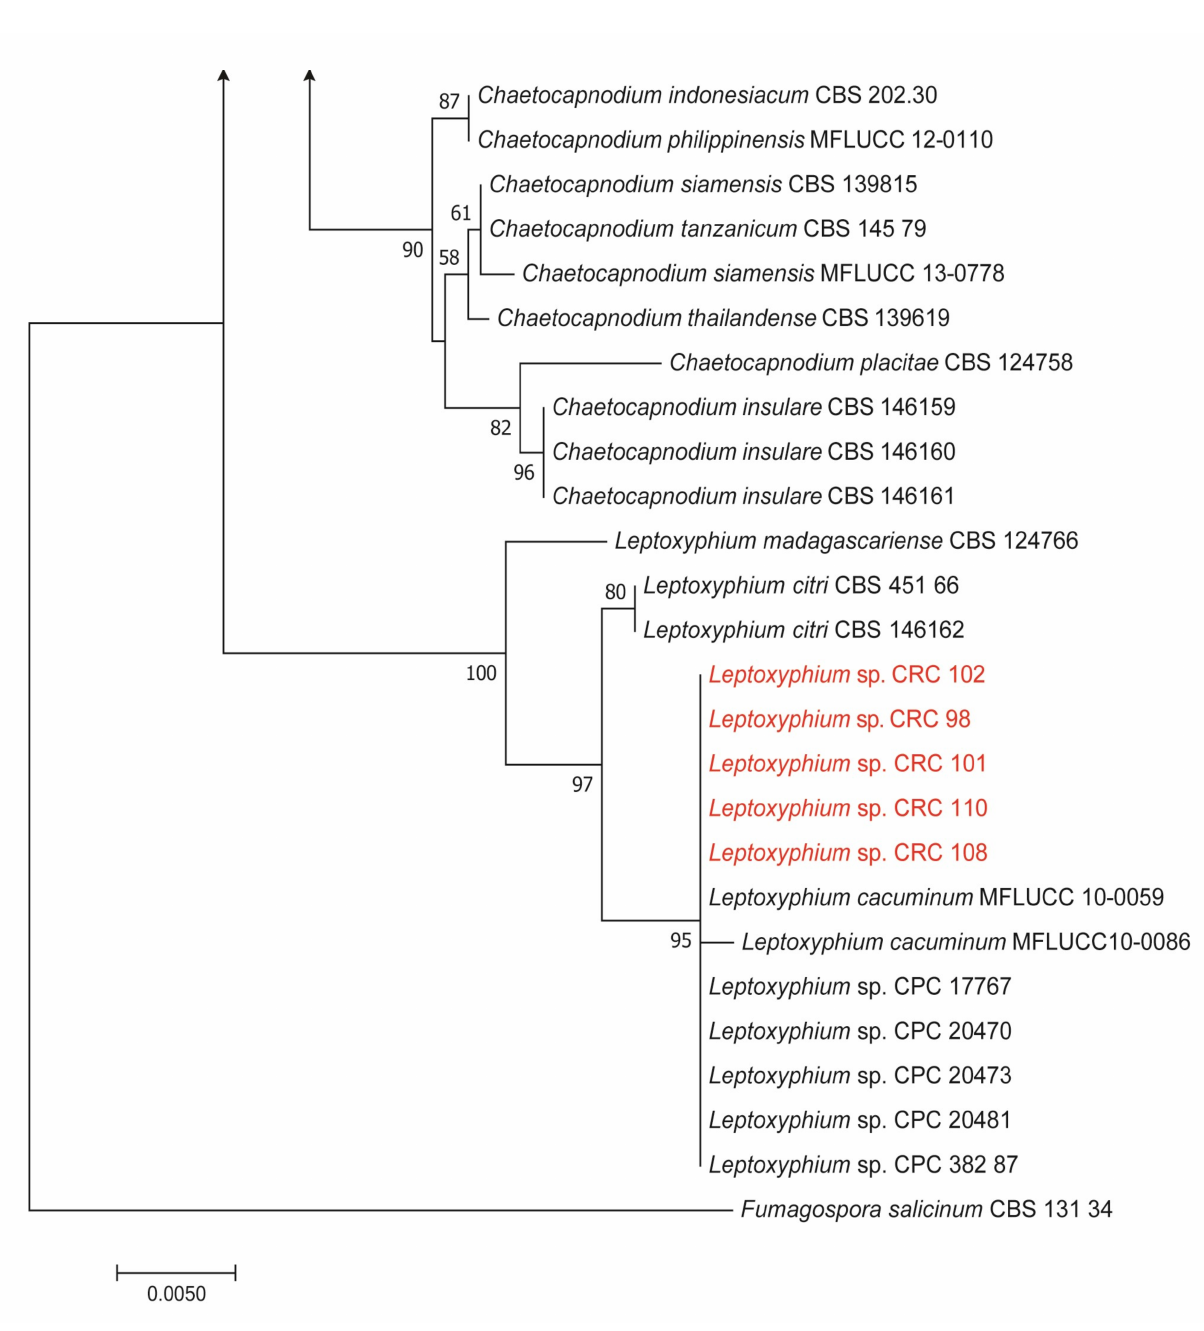
Figure 1. Neighbor-joining phylogenetic tree of Capnodiaceae generated based on the combined LSU and ITS. Bootstrap support values for neighbor-joining phylogeny equal to or higher than 50% are displayed on the nodes. The newly generated strains in this study are indicated in red. The tree is rooted to Fumagospora salicinum (CBS